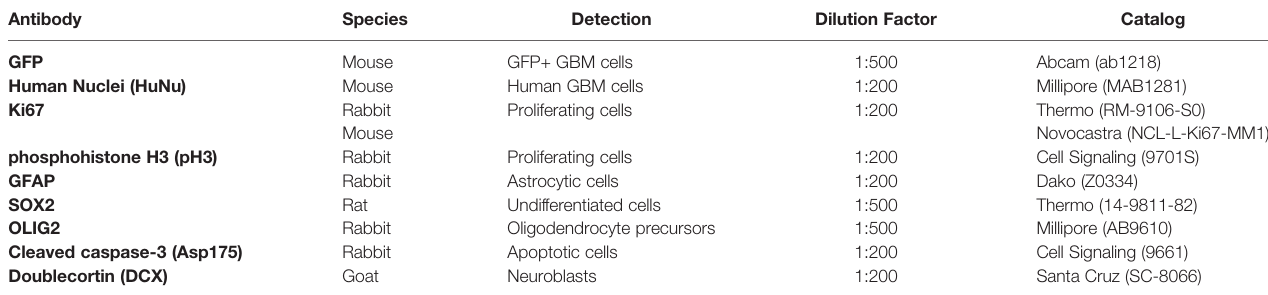
TABLE 1 | Primary antibodies used.